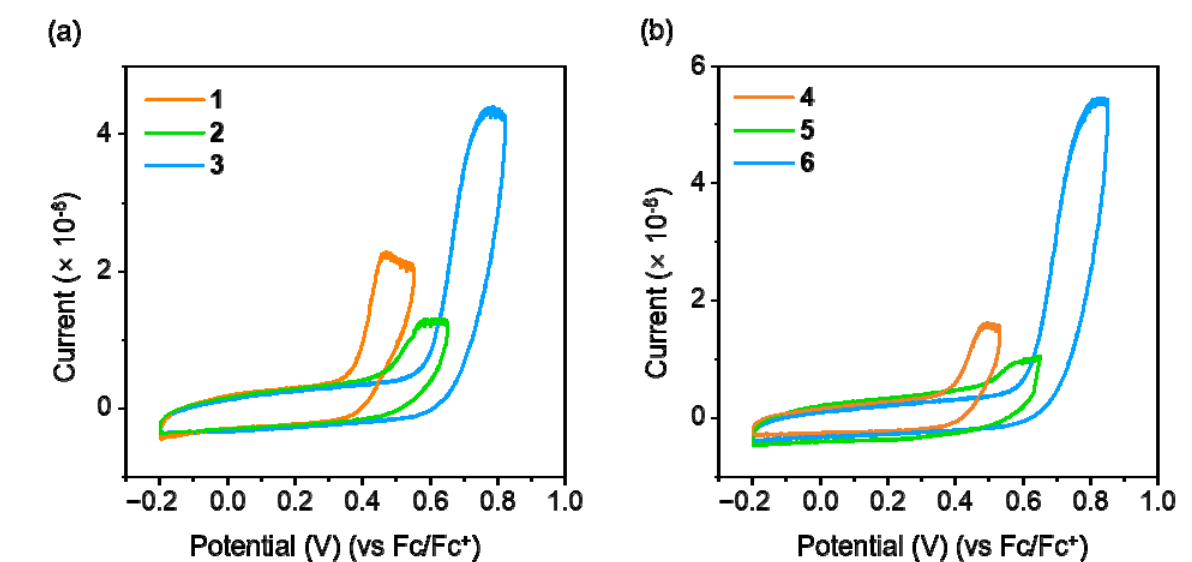
Figure 3. Cyclic voltammograms of the oxidation of ( a ) q-based complexes ( 1 – 3 ) and ( b ) Meq-based complexes ( 4 – 6 ) (0.5 mM in DMSO, scan rate = 100 mV/s for oxidation).